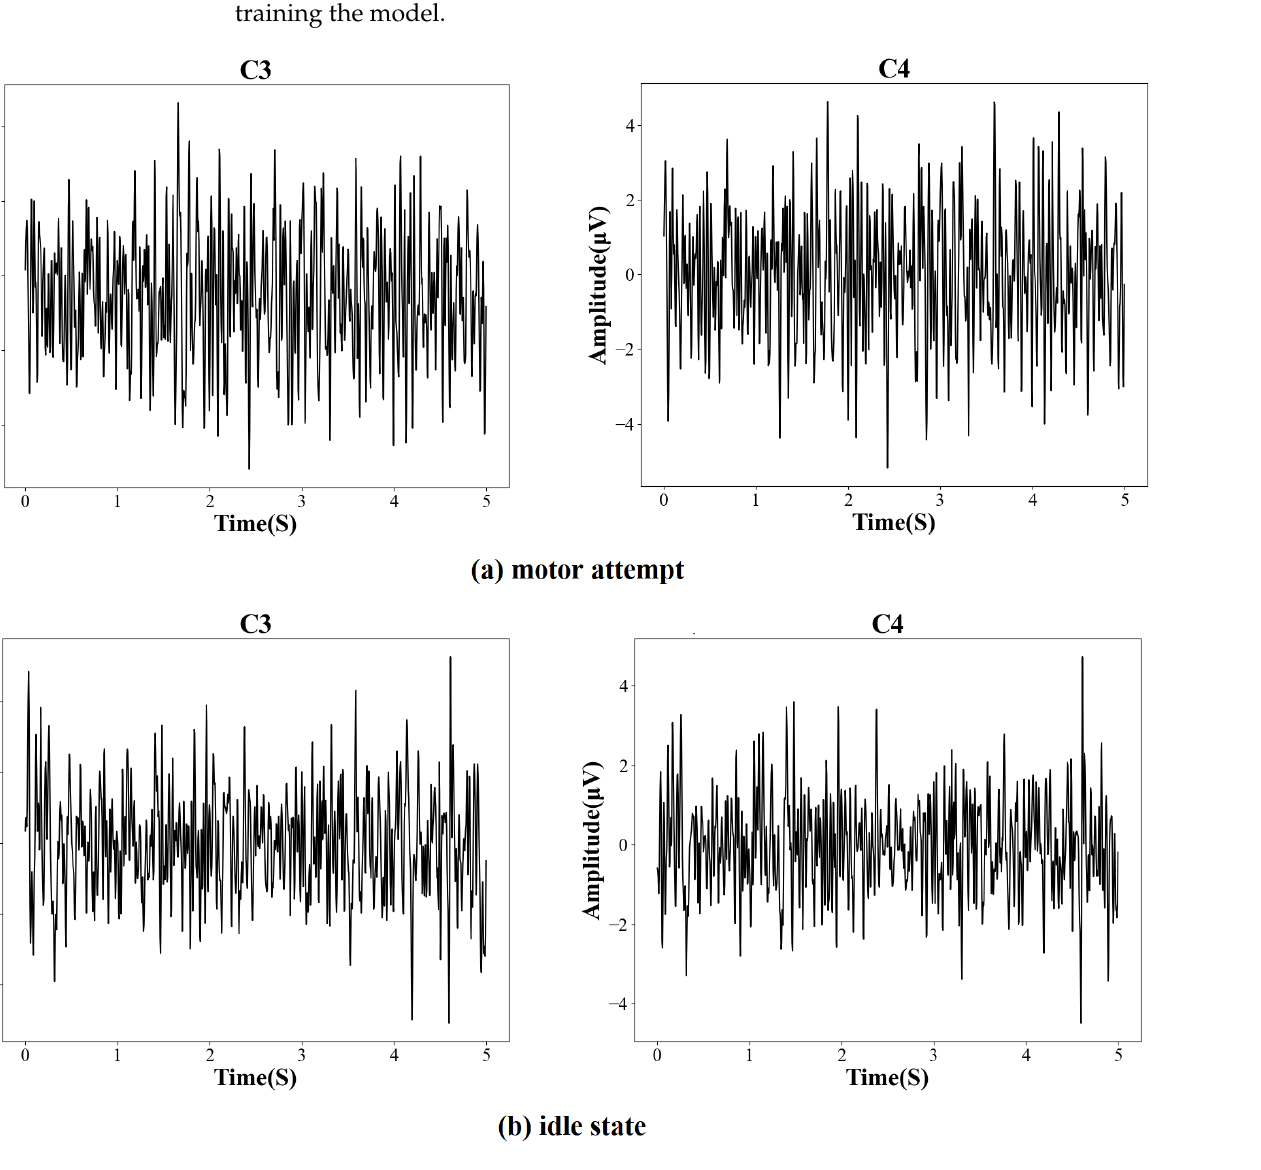
Figure 2. Examples of preprocessed EEG signals from different brain